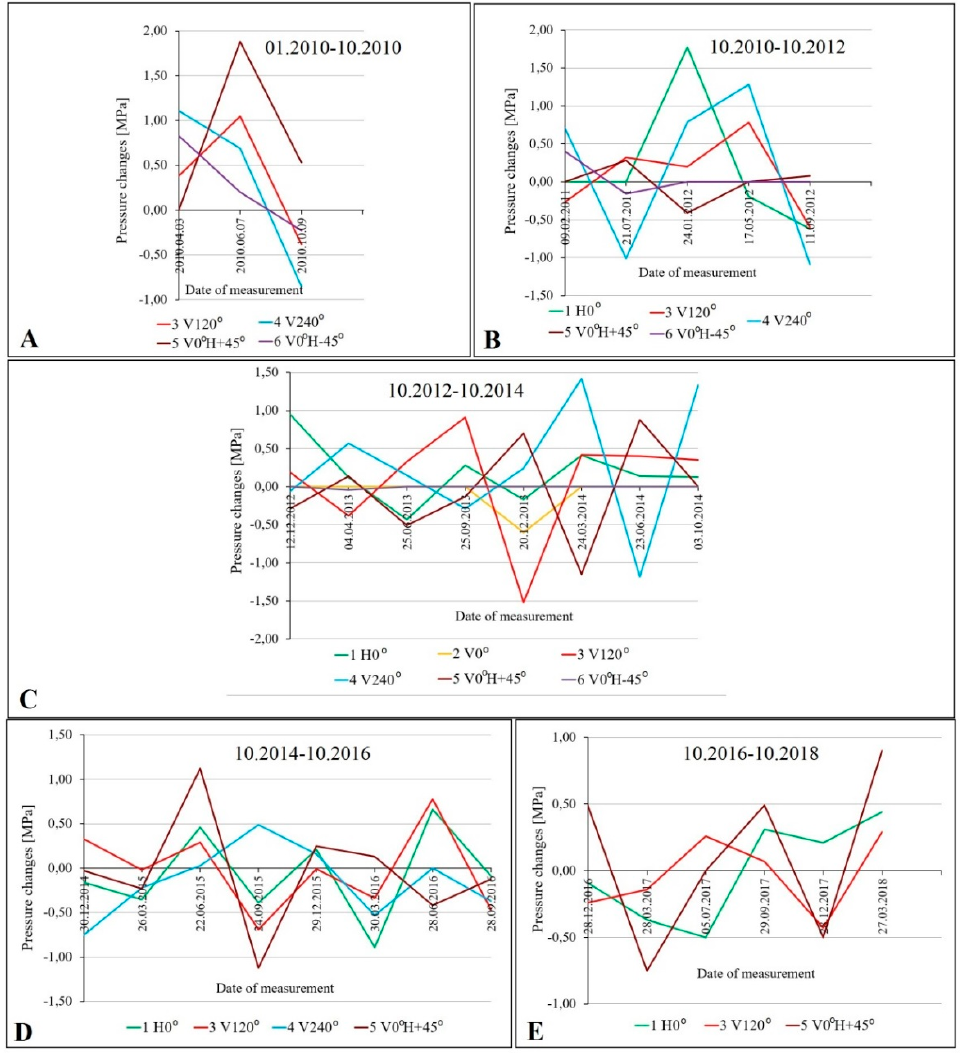
Figure 14. The changes in the pressure recorded by the AWID pads (compared to the lignite extraction progress presented in Figure